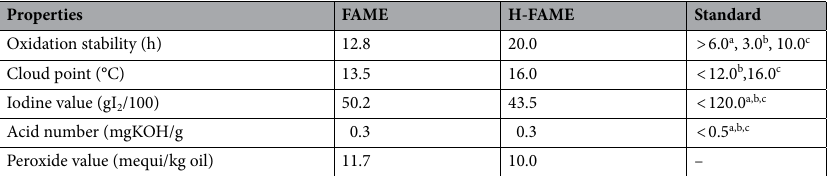
Table 2. Properties FAME and H-FAME compared to biodiesel standards (100 W, 1 mm gap, 80%H 2 , room temperature and 5 h). a EN14214 (European biodiesel standard). b ASTM D6751 (United States). c Thailand 51–53